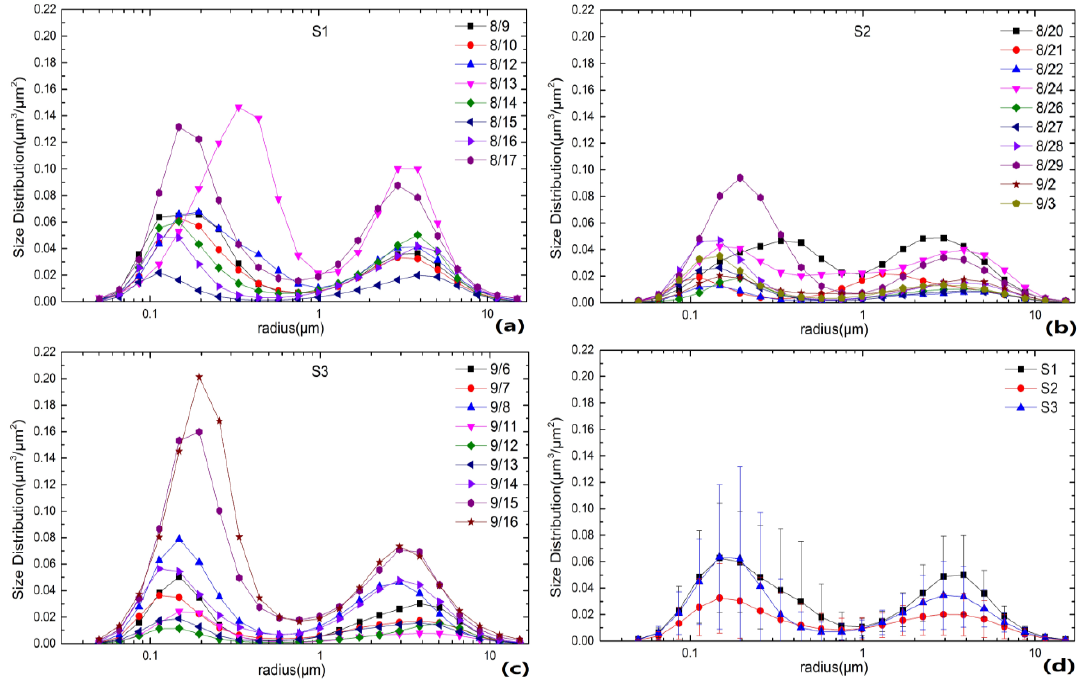
Figure 8. Daily average and stage average aerosol volume distribution.